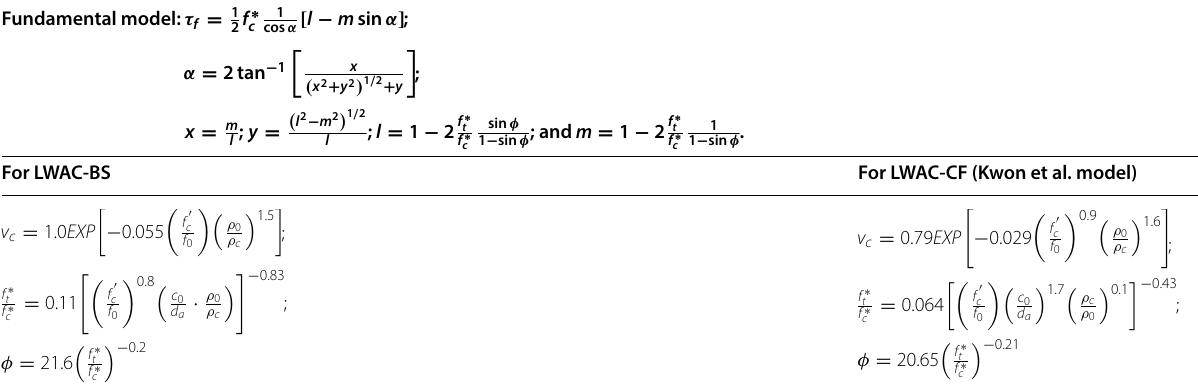
Table 4 Summary of shear friction strength model of LWAC.